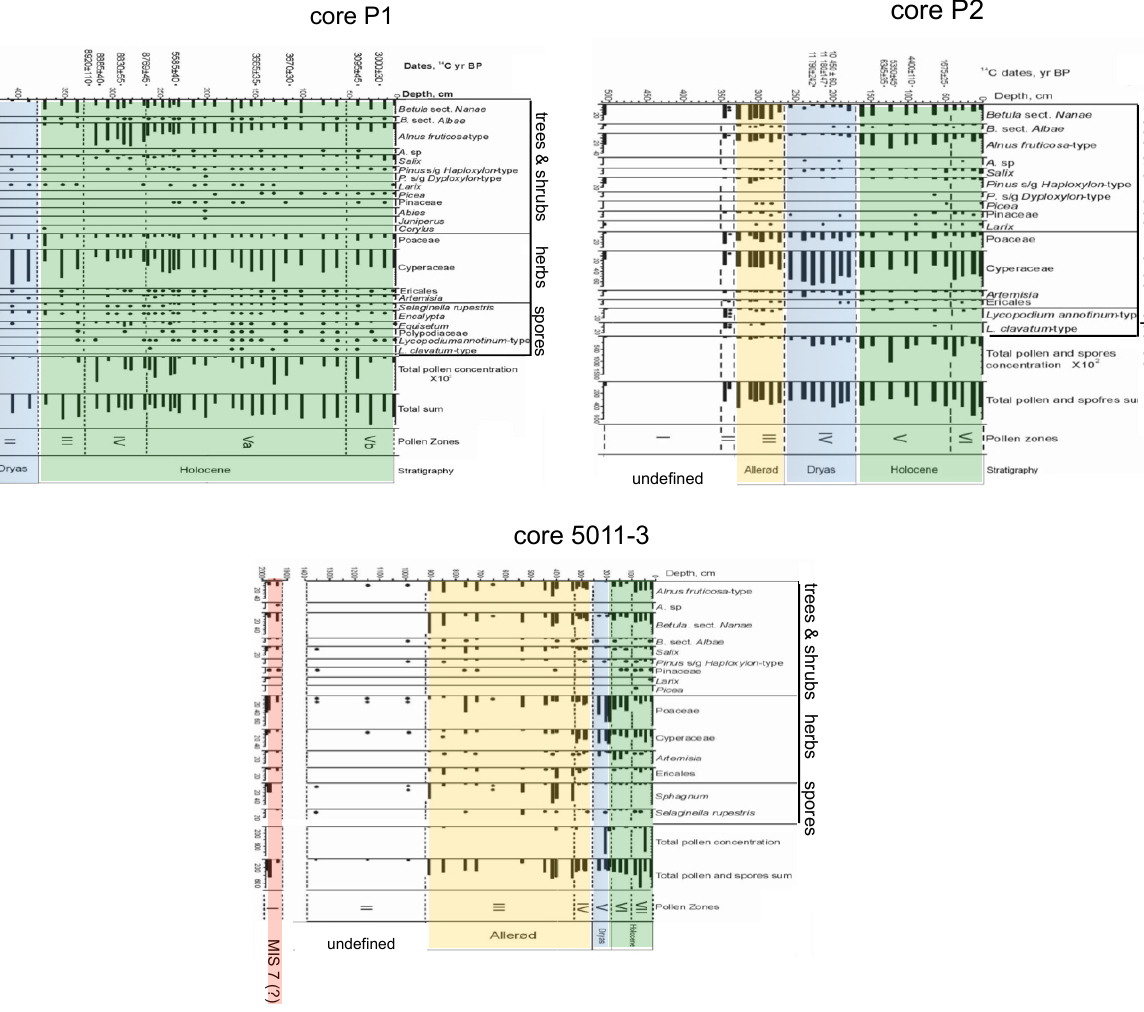
Fig. 8. Correlation of the pollen stratigraphy in permafrost core 5011-3 (bottom) with 14 C-dated cores P1 and P2 (from: Andreev et al.,